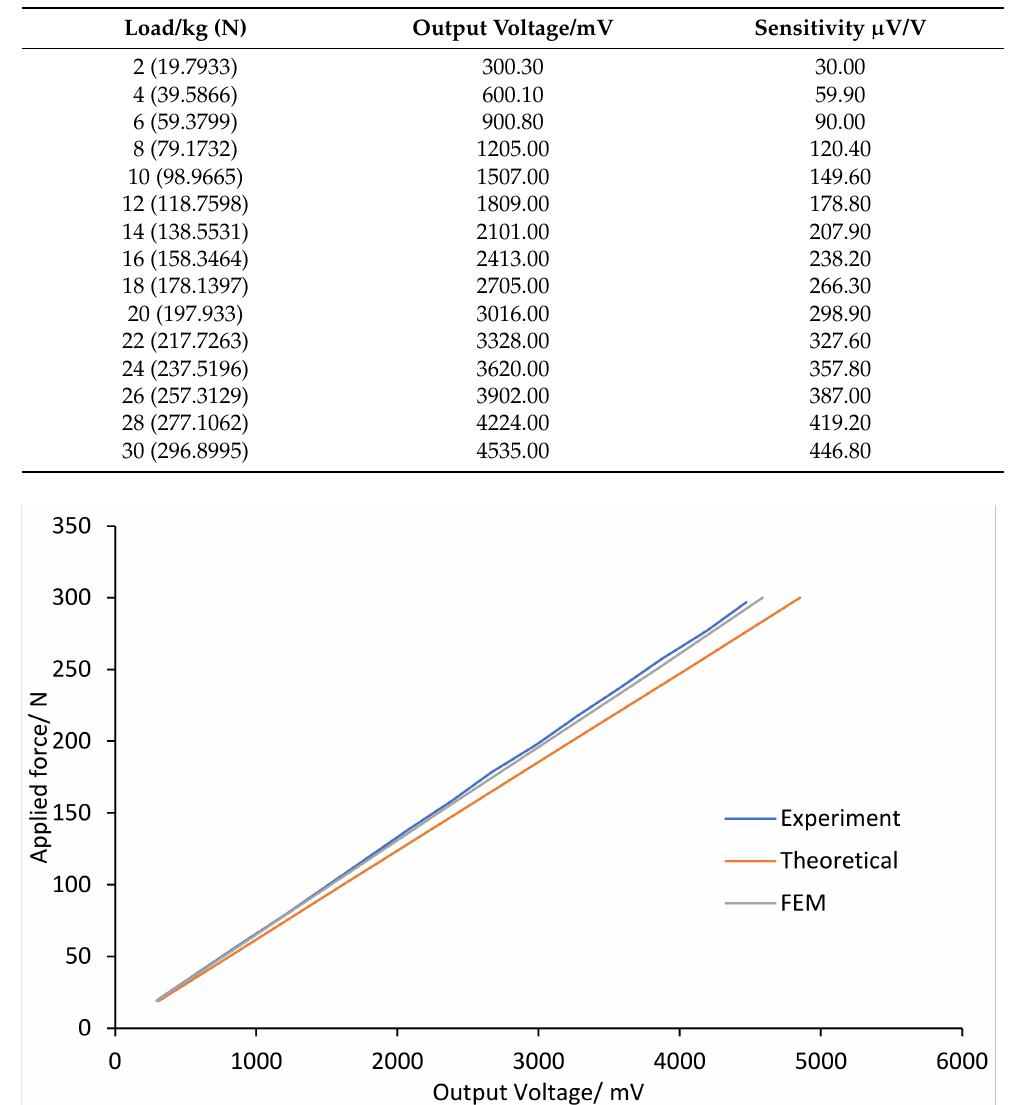
Table 3. Calibration results of the load cell by experiment.